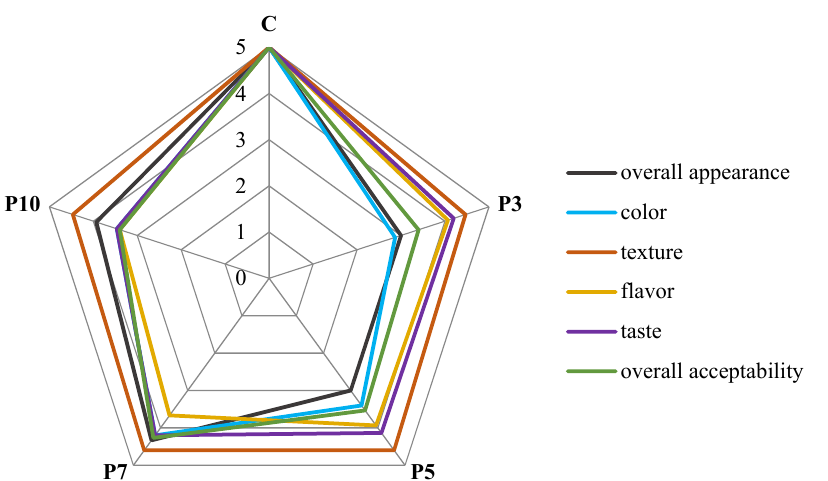
Figure 3. The scores of the sensory analysis of the obtained fresh pastas. C—control (semolina pasta); P3, P5, P7, P10—pasta samples with 3, 5, 7, 10 percentage replacement of semolina flour with spirulina powder.